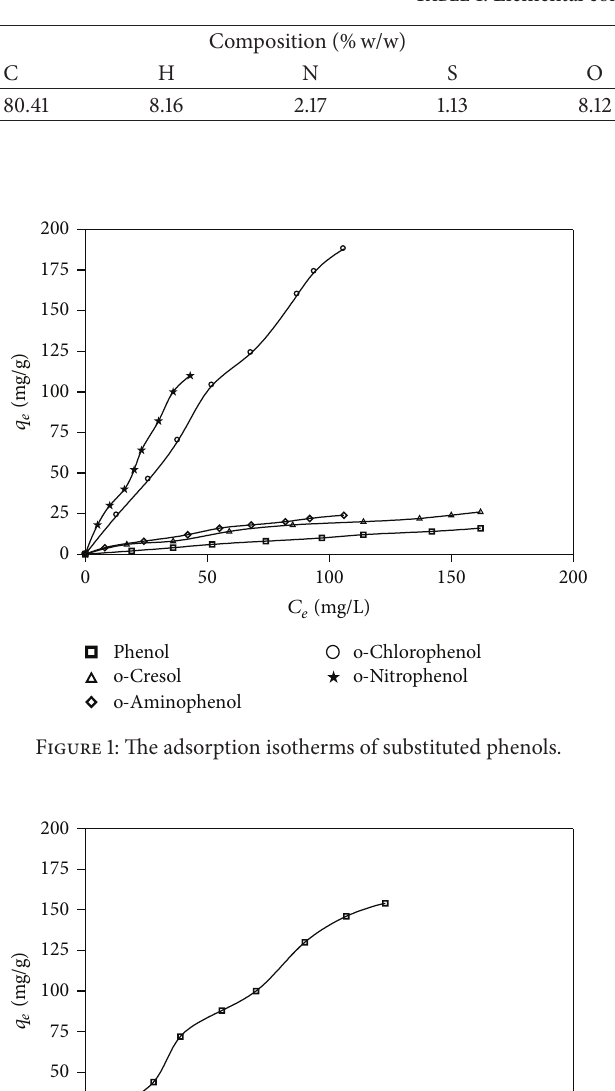
Table 1: Elemental composition of asphaltene.